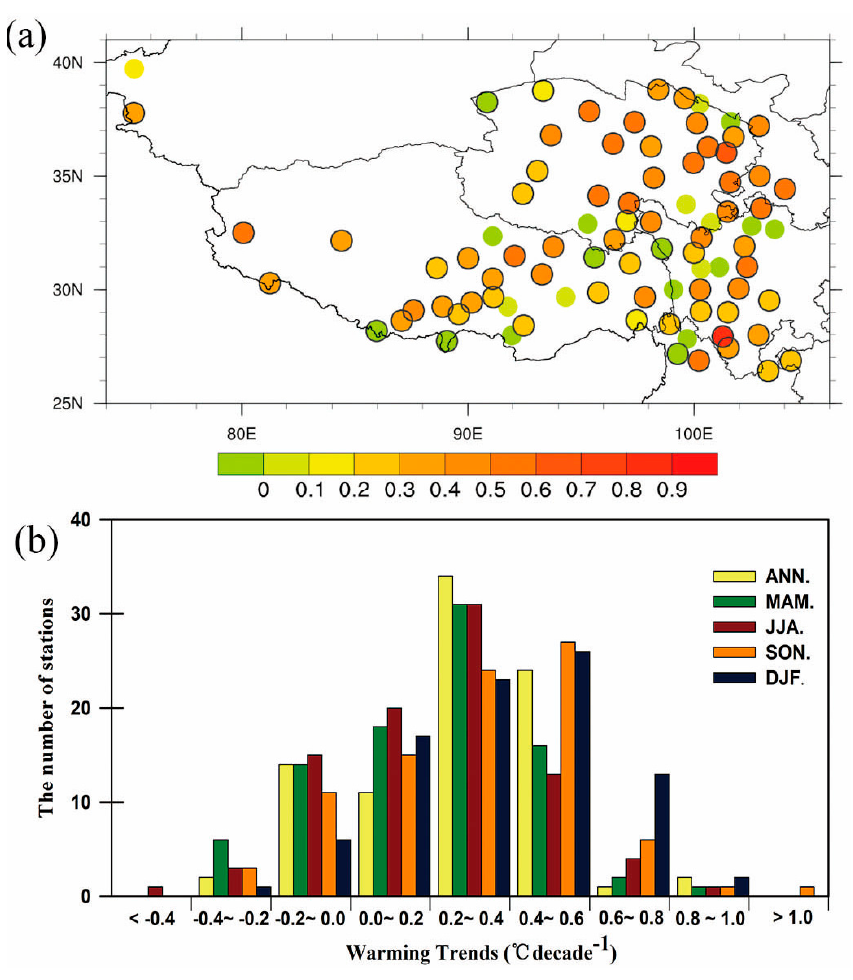
Figure 5. Similar to Figure 3, but for the maximum temperature. ( a ) Spatial distribution of annual temperature variations in 88 stations (points with blue circles indicate that they are significant at the 0.01 level); ( b ) The number of stations with different variation trends in annual and seasonal